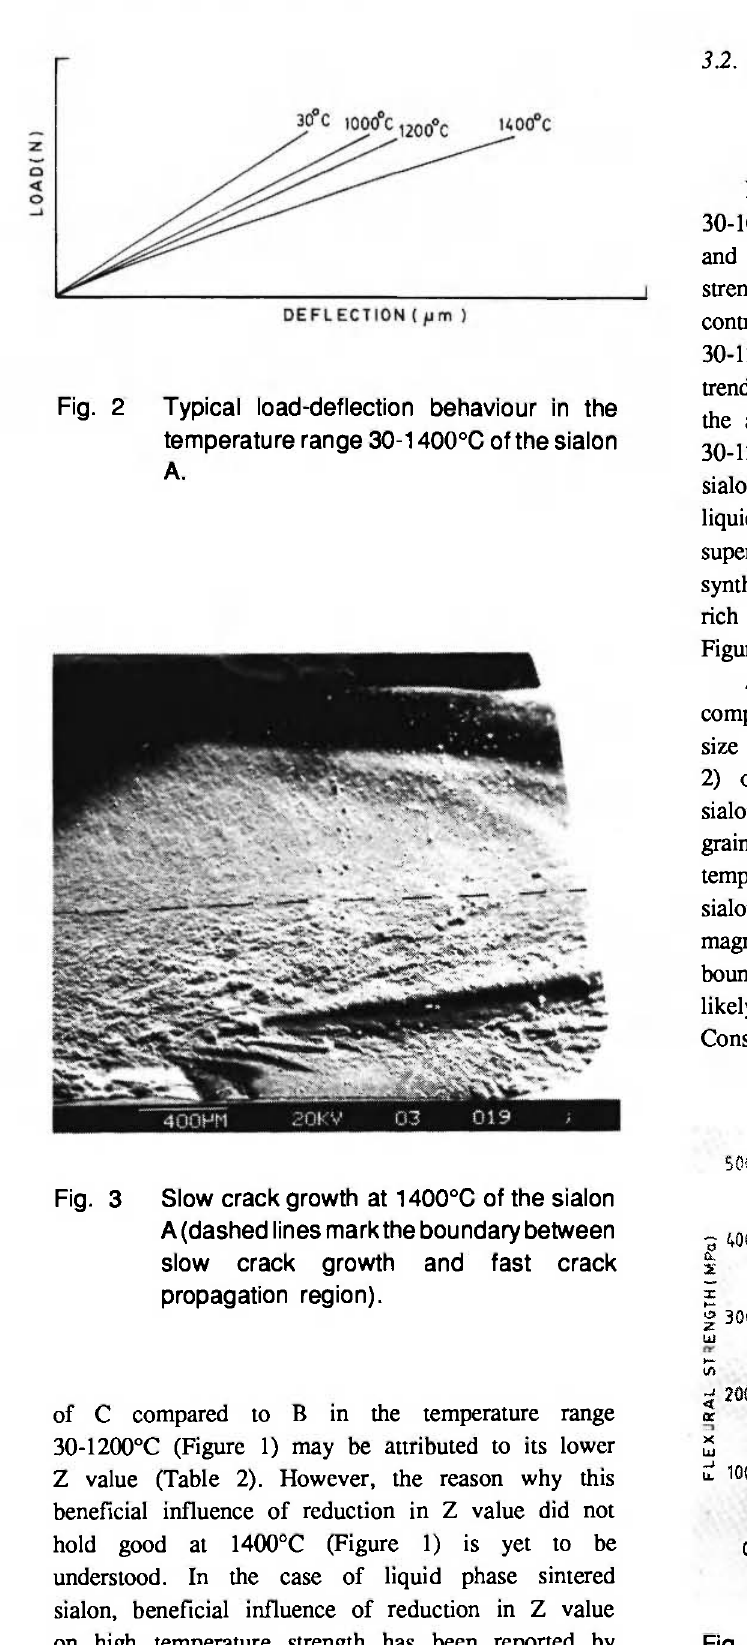
Fig. 4 High temperature strength of liquid phase sintered sialon D and